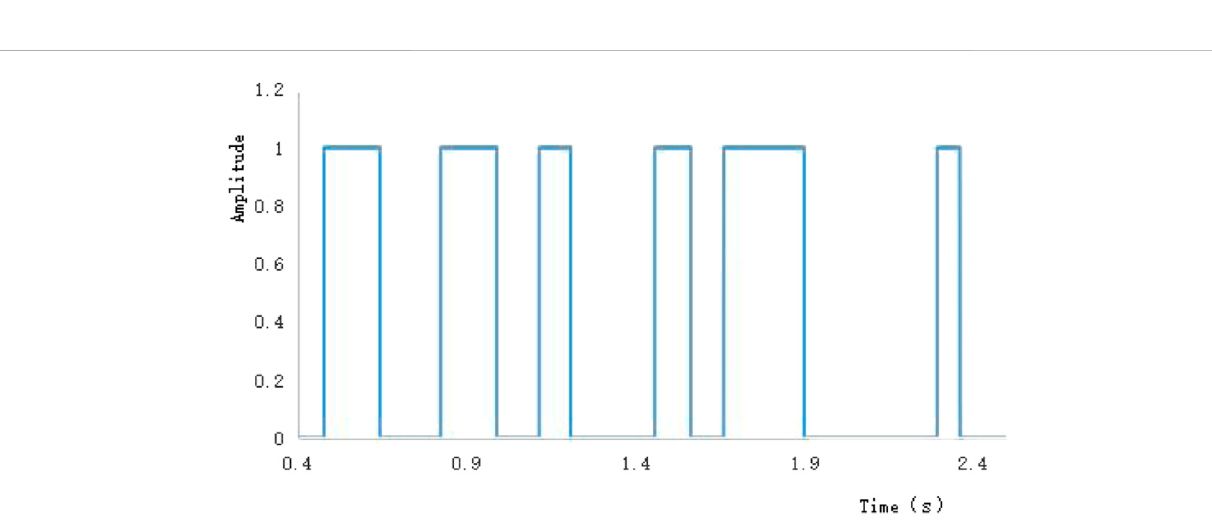
FIGURE 3 Rectangular signal.